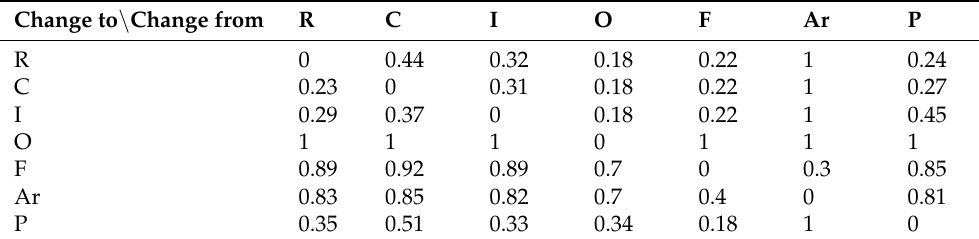
Table 1. Transfer coefficient, from a scale of 0 (change not possible) to 1 (no restrictions in swapping over) for changing land-use types. Abbreviations are as follows for the land-use type: Residential land (R), Commercial land (C), Industrial land (I), Arable land (Ar), Aquaculture land (Aq), Forest land (F), Other land (O), Beach (B), Public land (P), and Water (W). Columns are the source land use and rows are the changed land use.